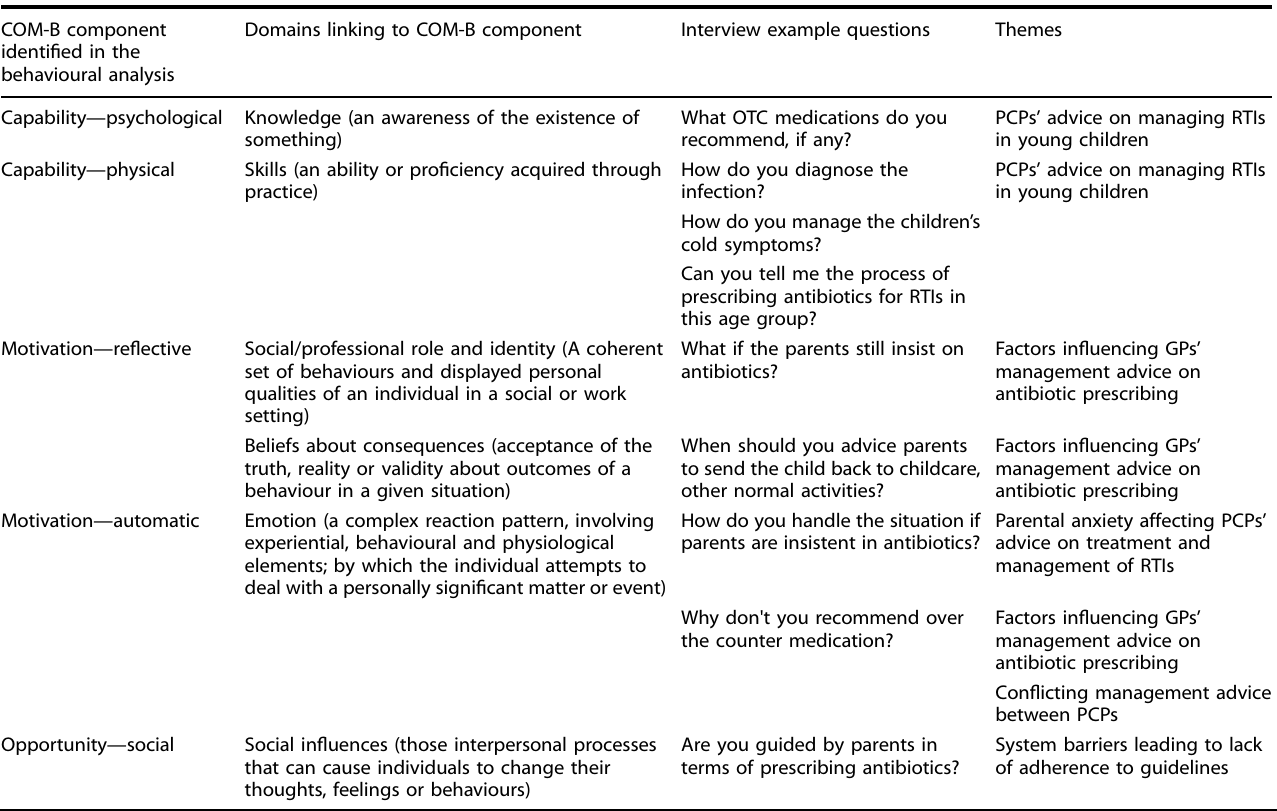
Table 1. Interview schedule using TDF and COM-B to determine themes COM-B component identi fi ed in